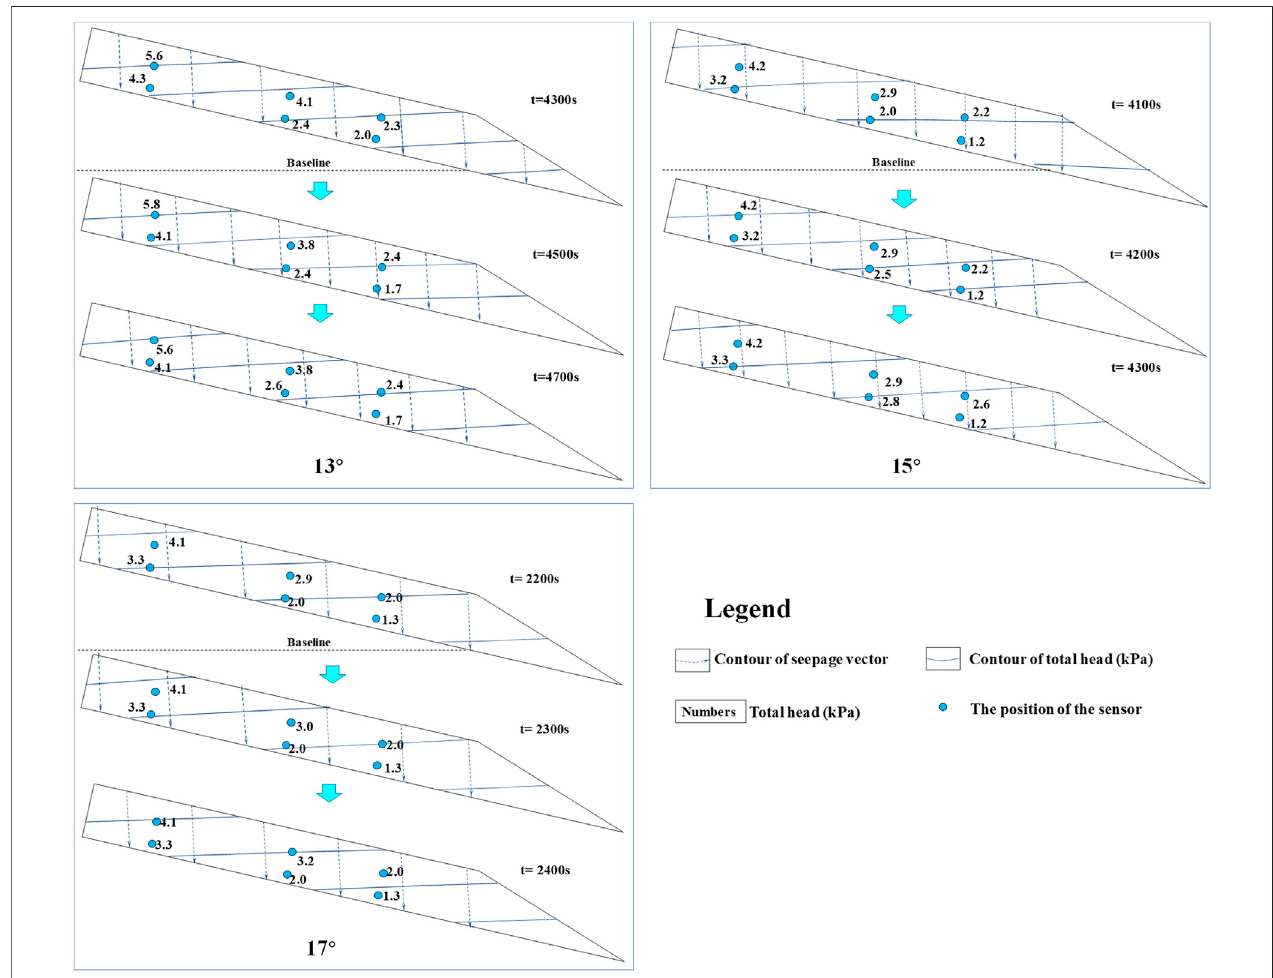
FIGURE 7 | Distribution of the seepage fi eld in the fl ume tests (the slope angle was respectively 13 ° , 15 ° and 17 ° ).